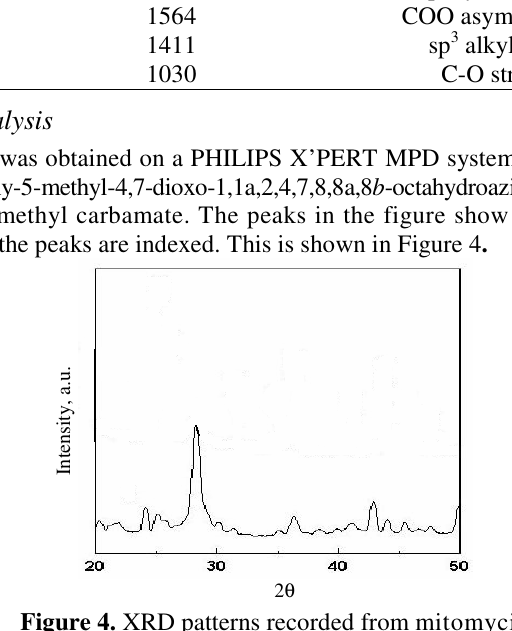
Figure 4. XRD patterns recorded from mitomycin